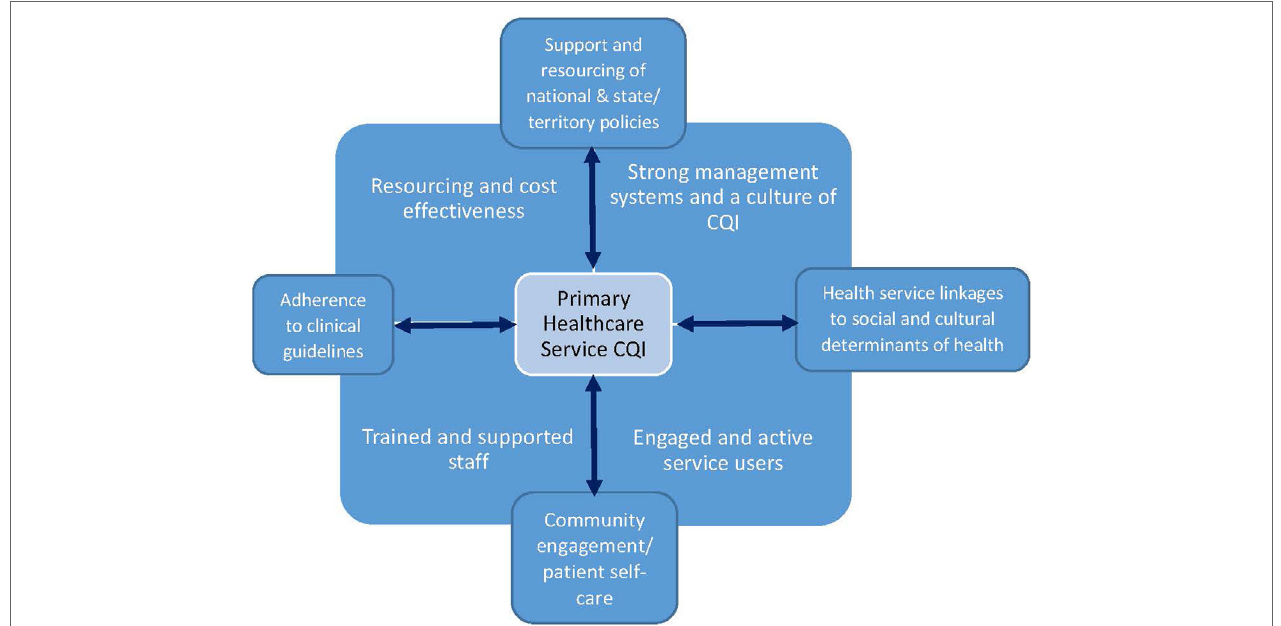
FiGUre 1 | The vertical and horizontal enhancement of continuous quality improvement